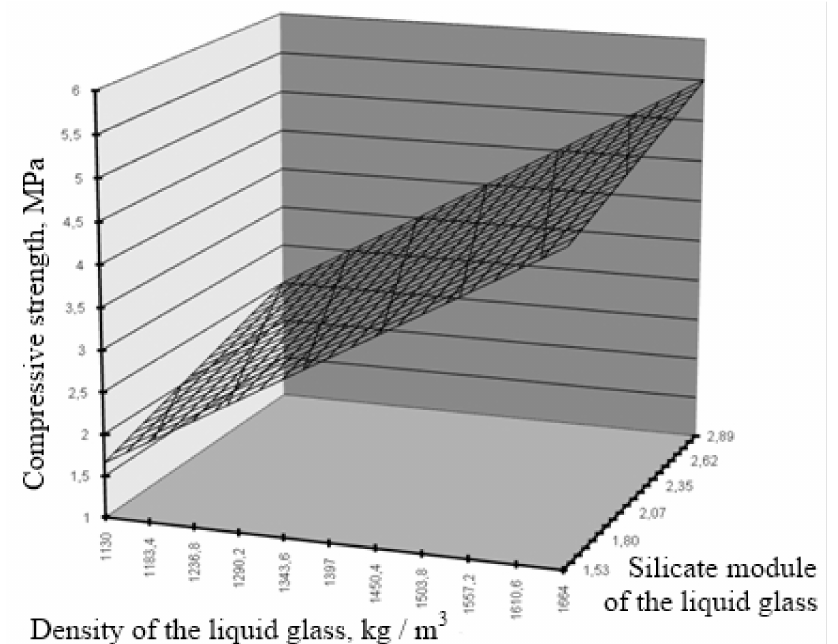
Figure 5. Dependence of compressive strength on the characteristics of liquid glass in the “lime + CSH” system.